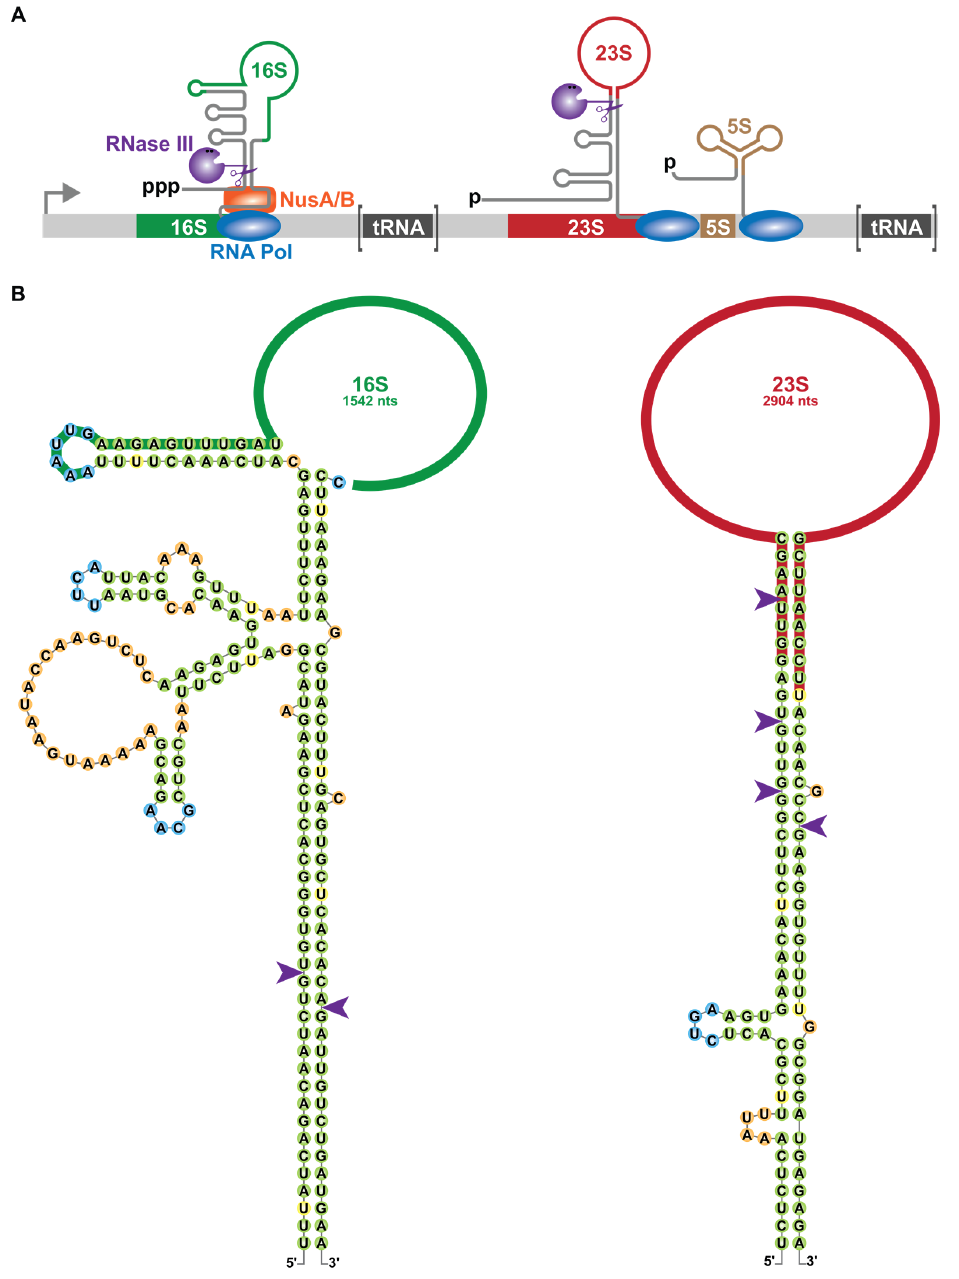
Figure 5. Co-transcriptional maturation of rRNAs by RNase III in E. coli . ( A ). Schematic representa- tion of an rRNA operon (not to scale). RNase III (purple) initiates the processing of the three rRNAs (16S in green, 23S in red and 5S in brown in a prototypical ribosomal operon) during transcription by RNA polymerase (blue) starting from the indicated promoter (bent arrow). NusA and NusB chaperone proteins are represented in orange, 5 ′ extremity of the triphosphorylated rRNA is represented by “ppp” and 5 ′ monophosphate extremities of the pre-23S and pre-5S rRNAs generated by RNase III cleavages are represented by “p”. ( B ). Secondary structures of Ec-RNase III cleavage sites within the 16S (in green) and 23S (in red) rRNAs of the rrsH - rrlH - rrfH operon were obtained from [116] and color-coded as in Figure